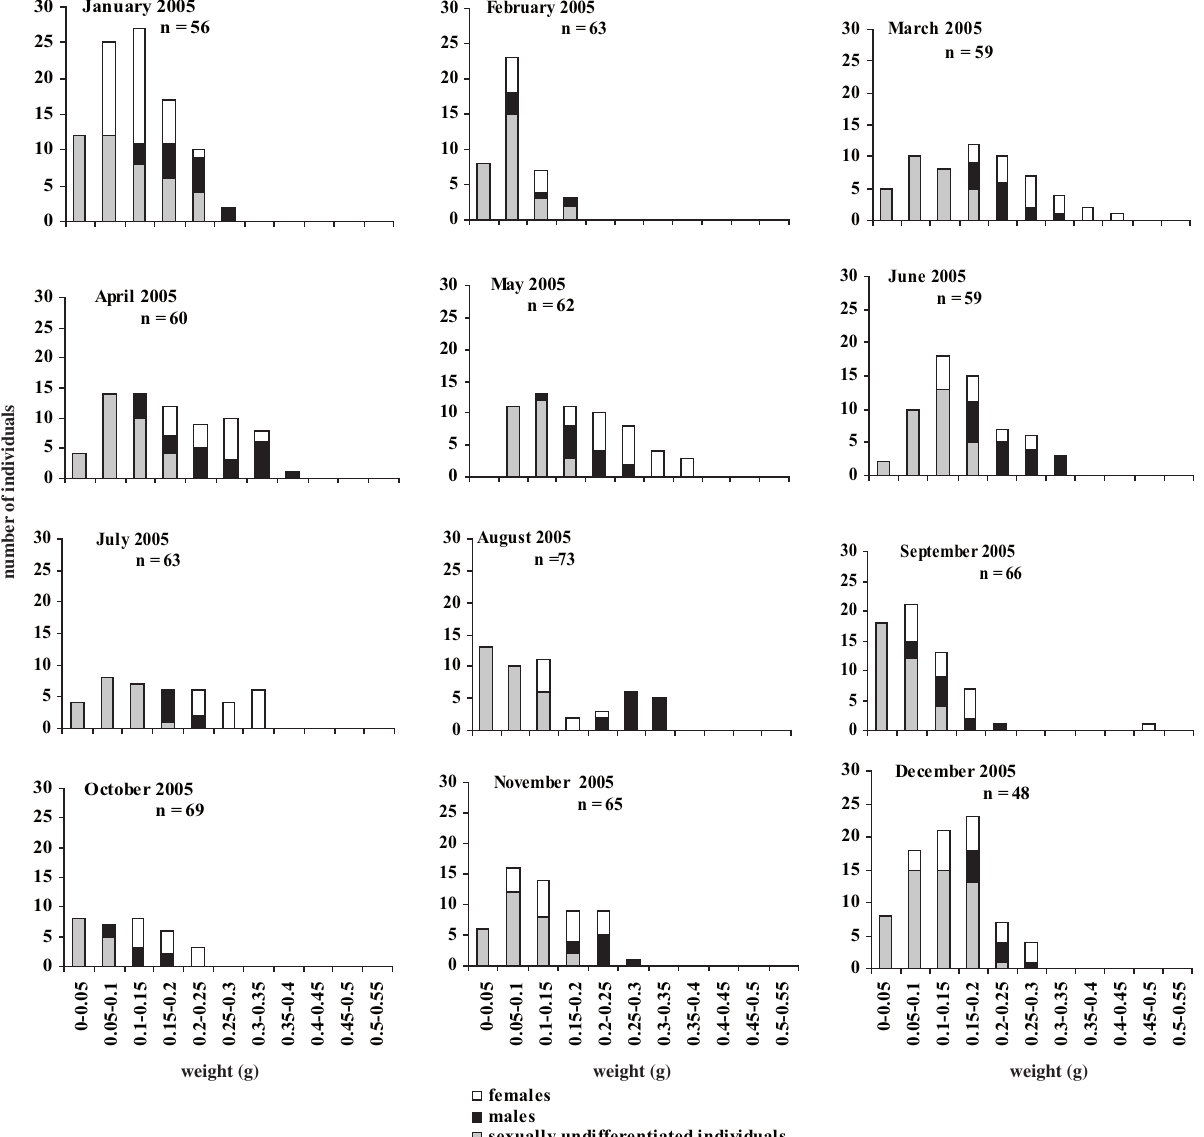
Fig . 8. – Size-frequency distribution based on whole body wet weight from January to December 2005 at Pointe